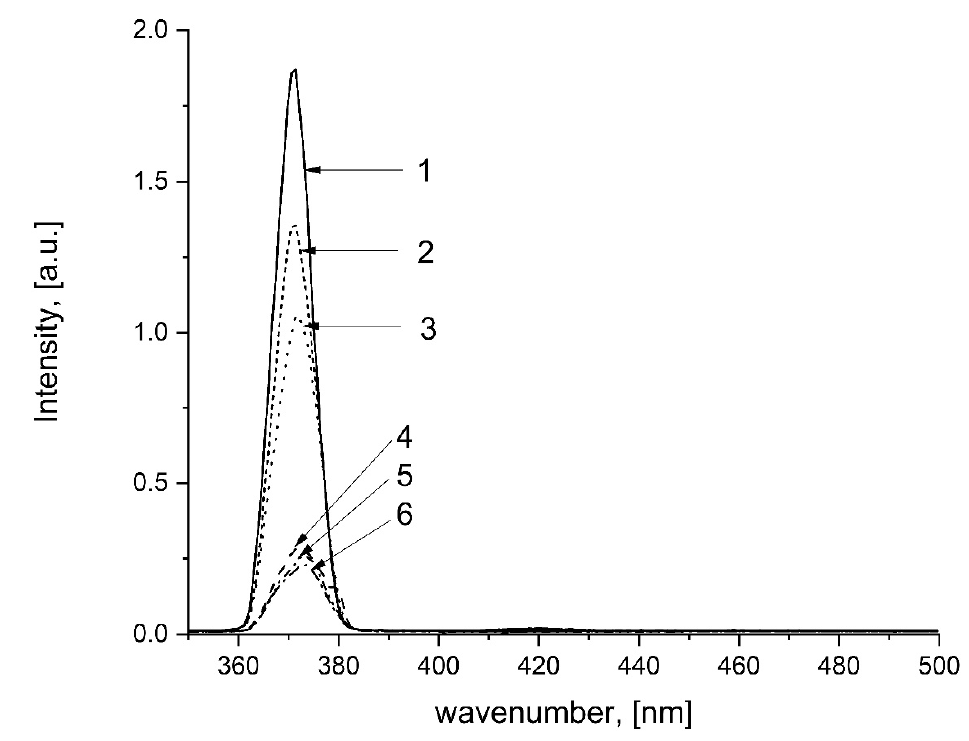
spectra of such water after the GP treatment regardless the GP treatment time are identical.